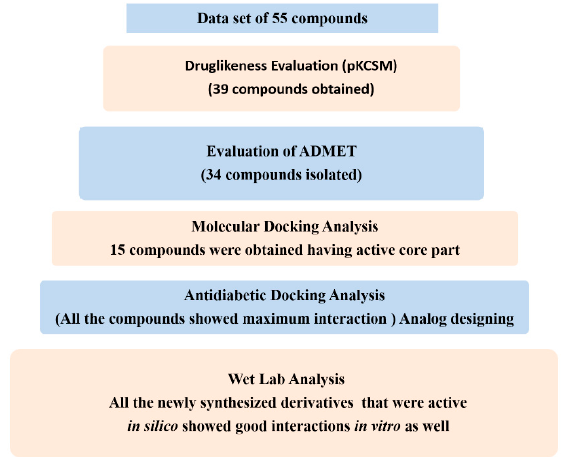
Figure 2. Summary of dry and wet lab analyses.